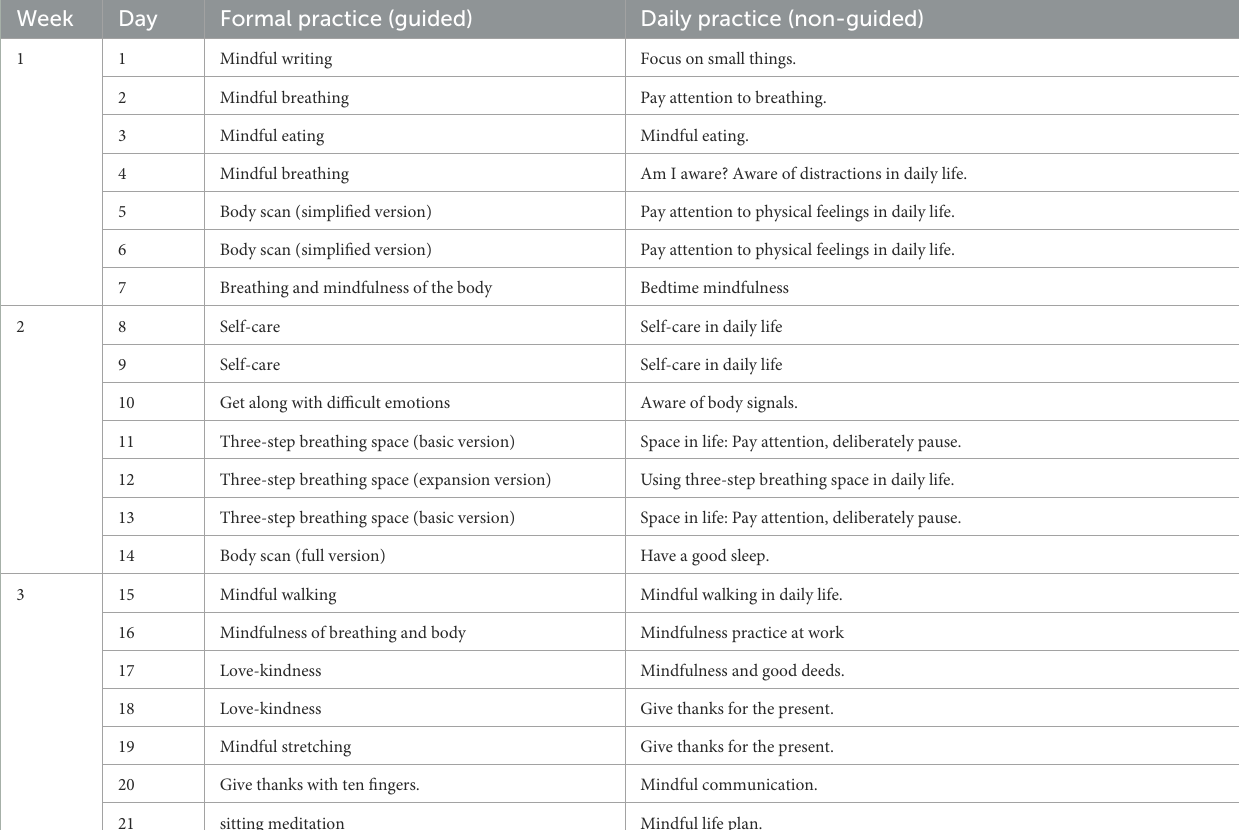
TABLE 3 The general content of the online mindfulness-enhanced